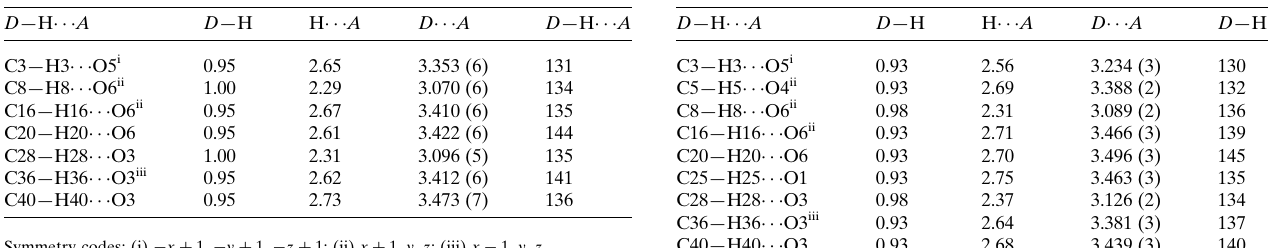
Table 1 Hydrogen-bond geometry (A˚ , (cid:3) ) for 1 .